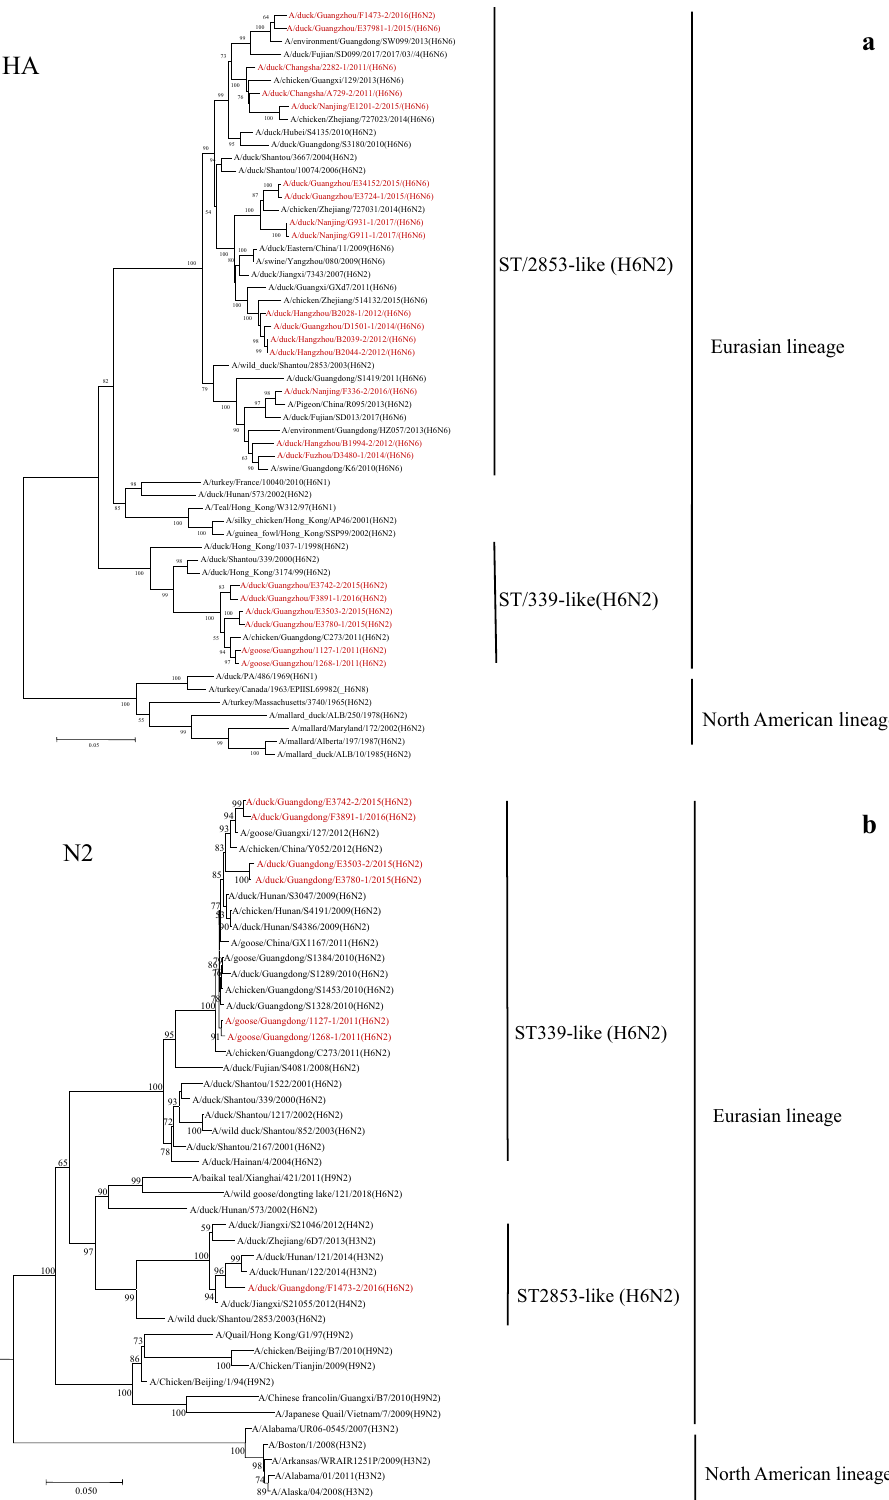
Figure 1. Phylogenetic trees of H6 AIVs isolated from 2011 to 2017 in Southern China. The phylogenetic trees of the H6 HA ( a ), N2 NA ( b ) and N6 NA ( c ) genes were generated by using the neighbor-joining method using MEGA 6.0. The genomic sequences of the viruses listed in black were downloaded from available databases; the viruses listed in red were evaluated in this study. The scale bar represents the distance between sequence pairs, and horizontal distances are proportional to genetic